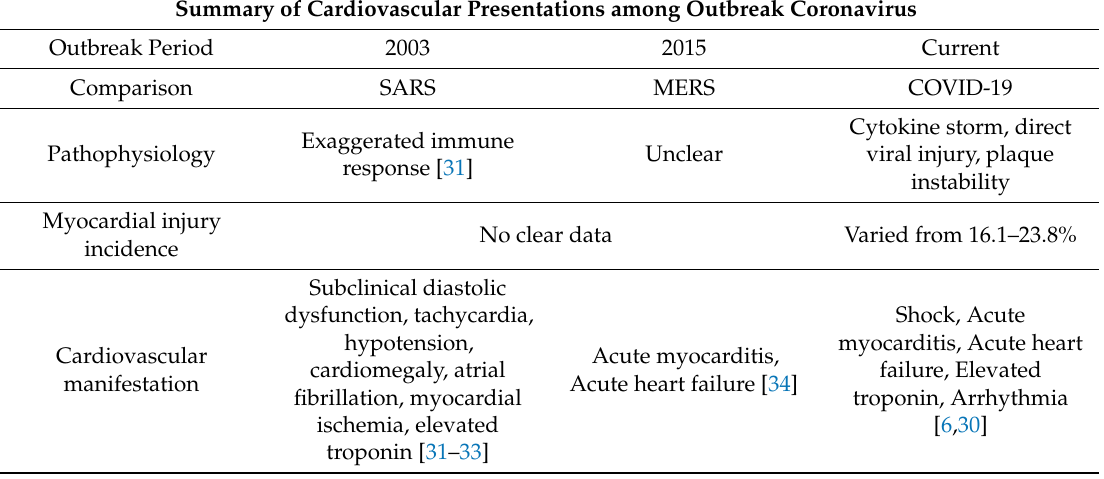
Table 2. Cardiovascular manifestation among recent epidermic / pandemic